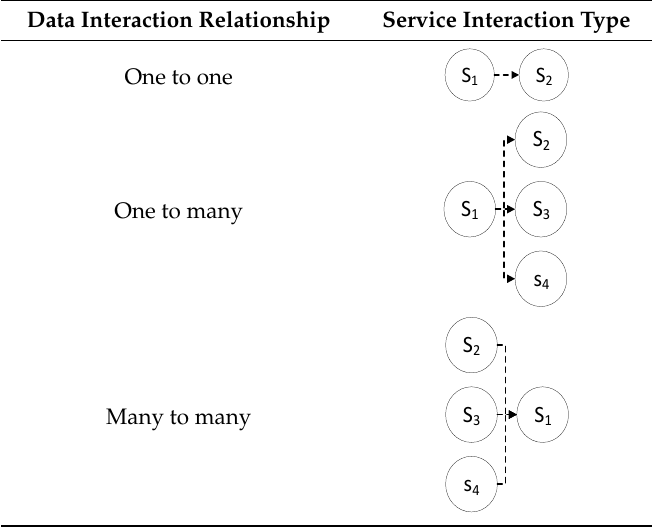
Table 3. Types of service interaction.